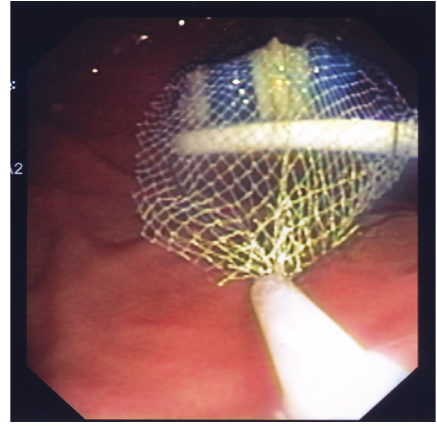
Figure 2: Attempted snare of toothbrush.